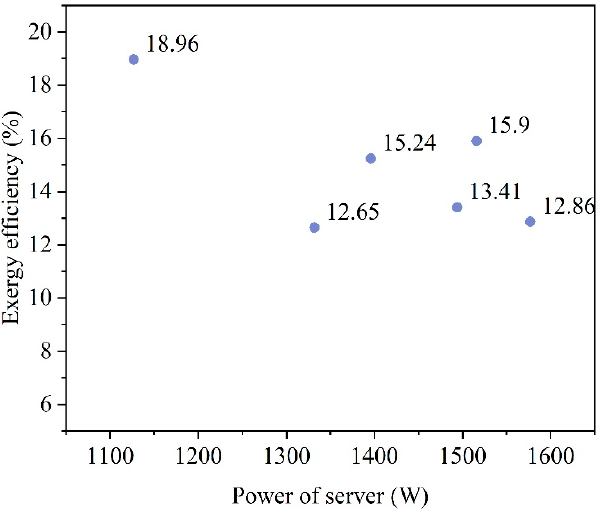
Figure 7. The exergy efficiency of the proposed two-phase cooling